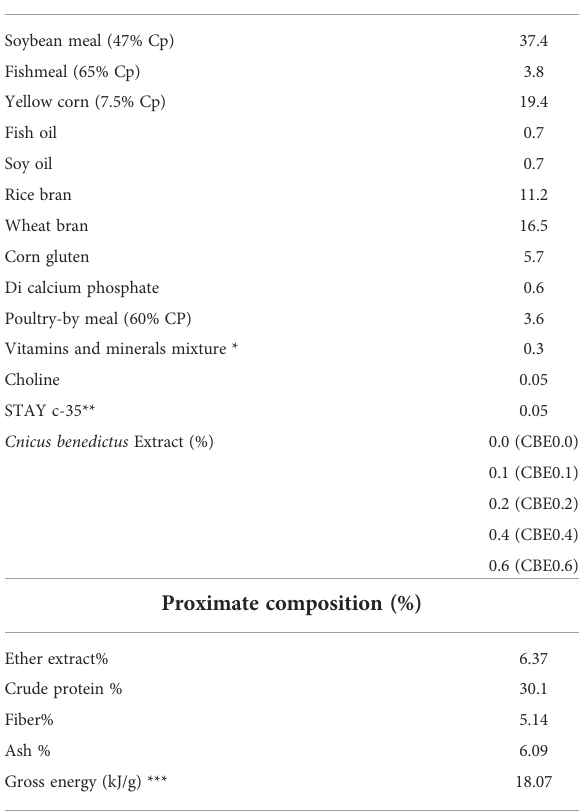
TABLE 1 Feed ingredients and proximate analysis of the experimental diets.